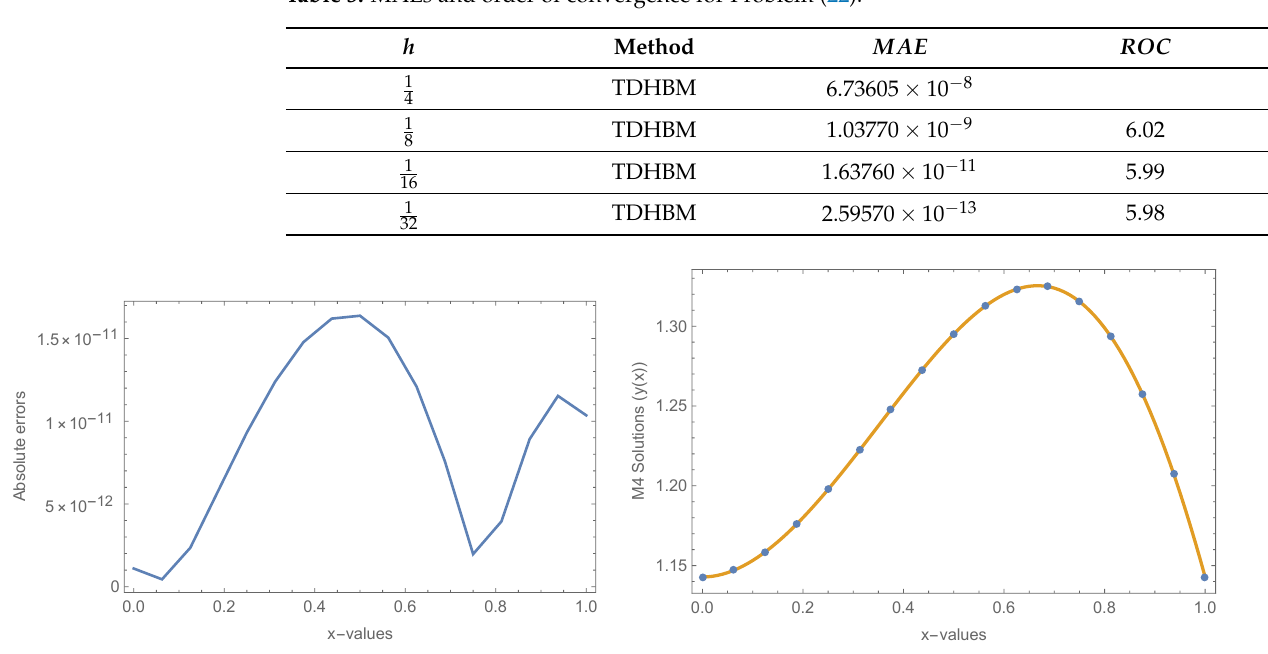
Table 3. MAEs and order of convergence for Problem (22).